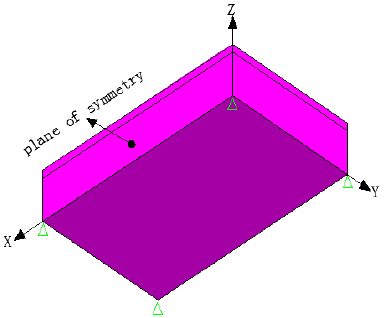
Figure 6. Applying boundary conditions.